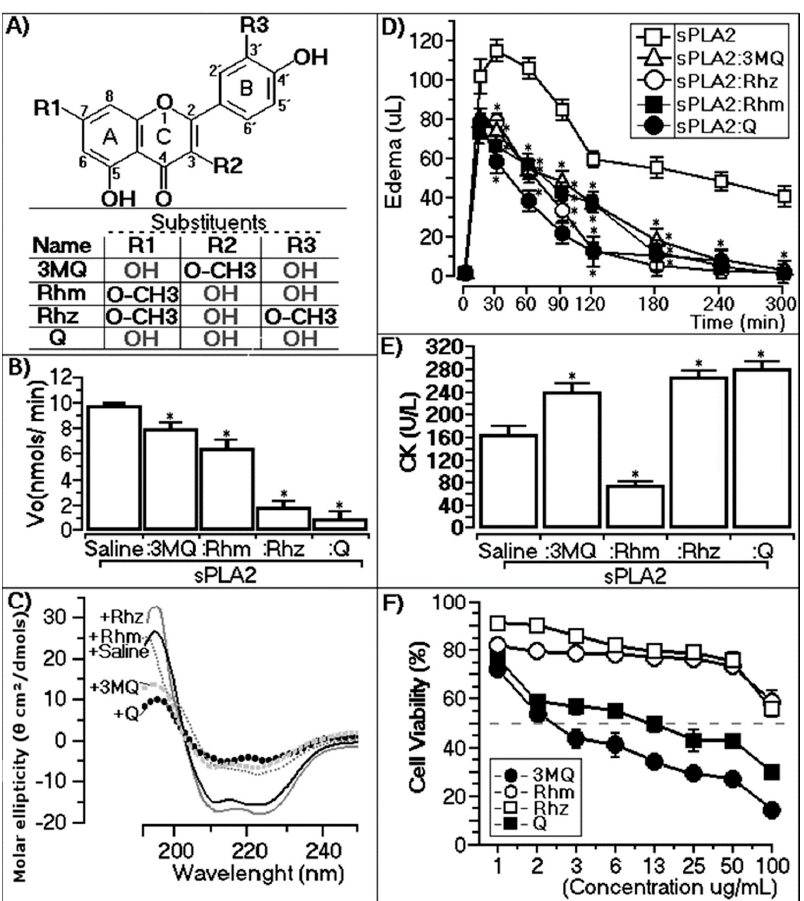
Figure 2. Structures of the quercetins assayed with the enzymatic, circular dichroism, edema, creatine kinase levels, and cytotoxic assays. ( A ) The structures of all flavonols assayed here and R1, R2, and R3 indicated the principal substituents found in all of the flavonols; ( B ) The effect of the previous treatment of the sPLA2 samples on the enzymatic activity after 30 min compared with native sPLA2. 3MQ, Rhm, Rhz, and Q. Each column represents the mean and SD of six replicates ( n = 6), and the asterisk (*) means p < 0.05; ( C ) CD spectra of isolated sPLA2 (saline) and all quercetins incubated